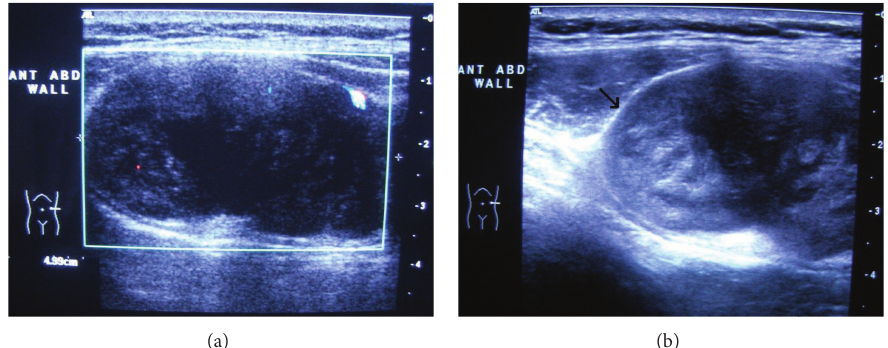
Figure1:(a)Colorflowshowinghypovascularityofthemass.(b)B-modeultrasoundshowsthewell-encapsulatedmassinanteriorabdominal wall (arrow).